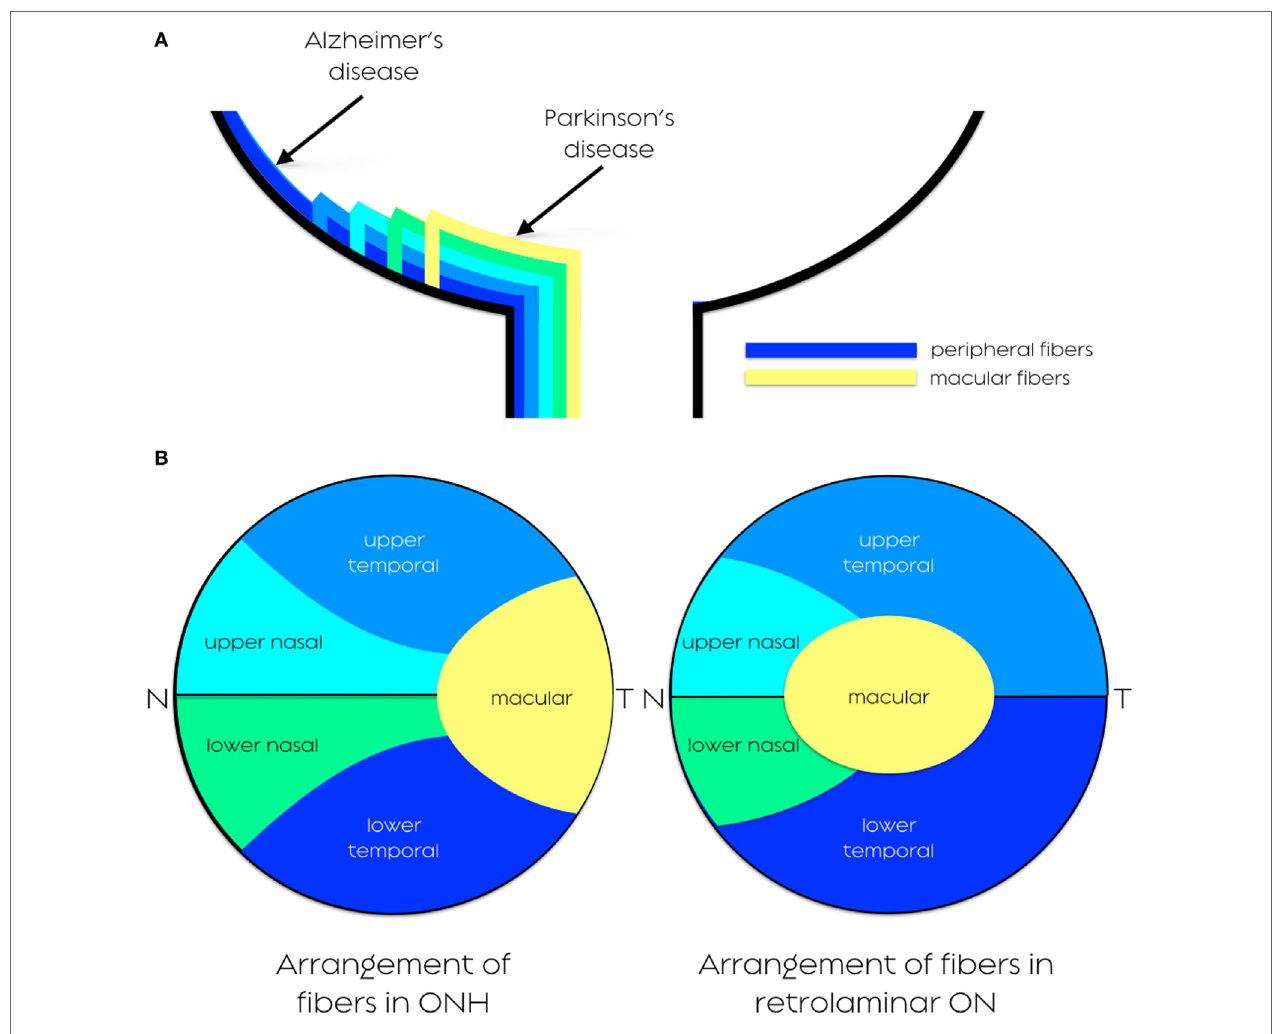
FiGURe 1 | (A) Distribution of retinal nerve fibers. Cross-sectional arrangement of axons, with deeper fibers originating from peripheral retina running closer to choroid occupying peripheral location in ONH, and superficial fibers originating nearer to the ONH occupy a more central portion of the nerve. (B) Arrangement of nerve fibers in the anterior visual pathway. In the pre-laminar, laminar, and proximal retro-laminar region of the ON, the axons from PMB are arranged temporally in the nerve but along the path to the LGN, they gradually shift centrally. ON, optic nerve; ONH, optic nerve head; PMB, papillomacular bundle; LGN, lateral geniculate